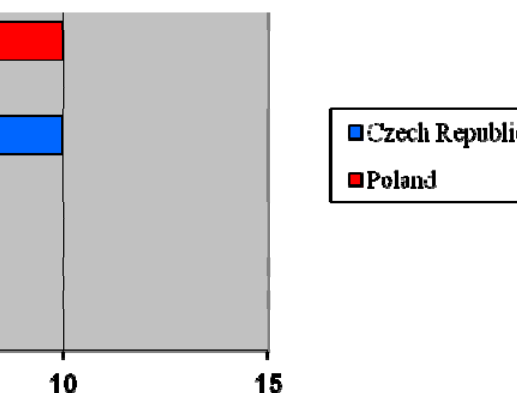
Figure 1. Number of homeless people, definition and legislation.